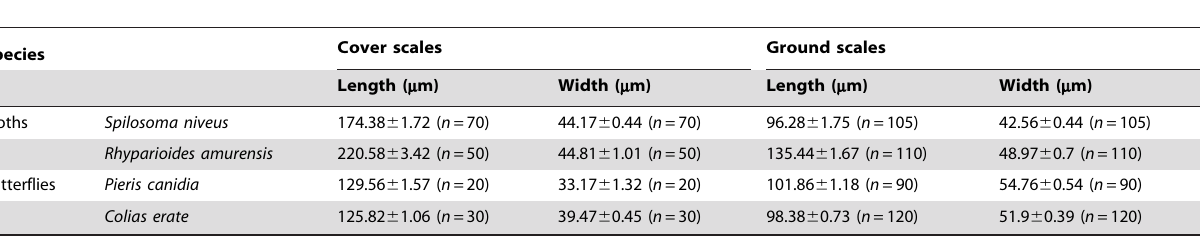
Table 1. Characteristics of cover scales and ground scales in the moths and butterflies.